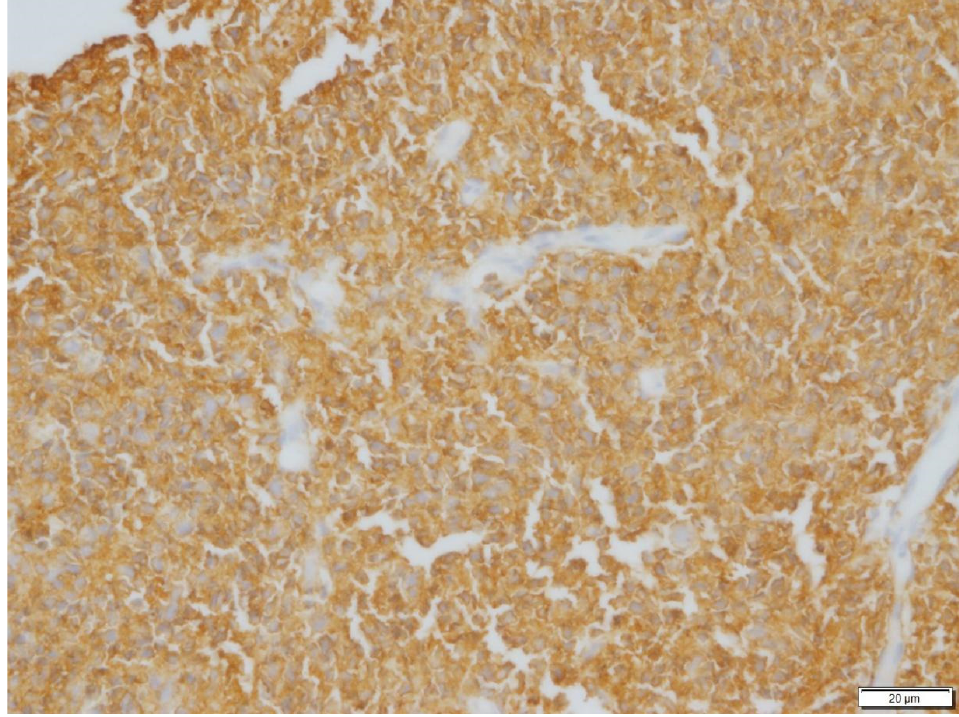
Figure 6. Immunohistochemical stain of neoplastic cells in Case N.2. Neoplastic cells exhibited strong immunoreactivity for CD20. Immunohistochemical stain CD20 (400× magnification). The patient was started on 2 mg chlorambucil three times a week (approximately 6 mg/m2 EOD), as well as prednisolone 5 mg daily, progressively tapered down. Rechecks were carried out monthly and no side effects or hematological and biochemistry abnor- malities relating to chlorambucil were noticed. The cat markedly improved after starting the treatment and remained in remission for 9 months, until he developed two episodes of suspected full and partial seizures. However, no clinical signs of nasal lymphoma were present. A restaging with blood work, thoracic radiography and CT scan of the head and neck were repeated. CT scan did not reveal any abnormalities in the nasal cavity and crib- riform plate was intact. However, a small intracranial extra axial mass (1.5 × 1.0 × 0.4 cm diameter) was found in the left olfactory region of the frontal lobe. The most likely differ- ential diagnoses included an intracranial extension of the lymphoma or a meningioma. The patient was started on levetiracetam and switched from chlorambucil to lomustine and cytarabine, due to better blood–brain barrier penetration. However, during the fol- lowing two weeks, his neurological signs deteriorated, with more seizure episodes, and the owner elected for euthanasia. Unfortunately, postmortem examination was not per- mitted, so it was not possible to confirm the nature of the mass in the brain. Chlorambucil and prednisolone-specific DFI and survival time were, respectively, 9 and 10 months. 2.1.3. Case N.3 Aged 16 years and 5 months, a male neutered domestic short-haired cat presented with chronic unilateral (right) mucopurulent nasal discharge of three-month duration and occasional sneezing. On initial physical examination, he was bright, alert and responsive. The cat was overweight at 6.0 kg, with a BCS of 8/9. The patient had mucopurulent nasal discharge and reduced air flow from the right nostril, but no exophthalmos or facial deformity were noted. Retropulsion of both eyes was negative for mass effects, regional and peripheral lymph nodes were within normal limits and abdominal palpation was unremarkable. On